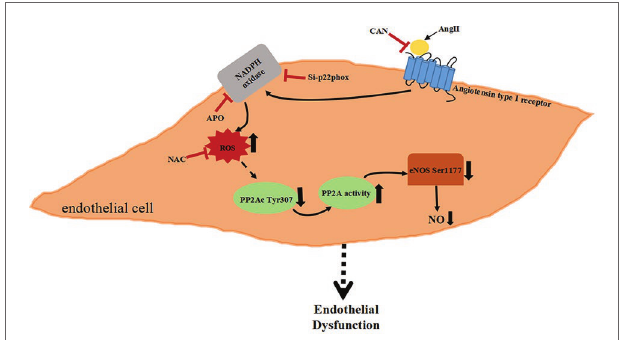
FIGURE 5 | Schematic diagram of AngII-activated PP2A downregulate eNOS phosphorylation via the Nox/ROS signaling